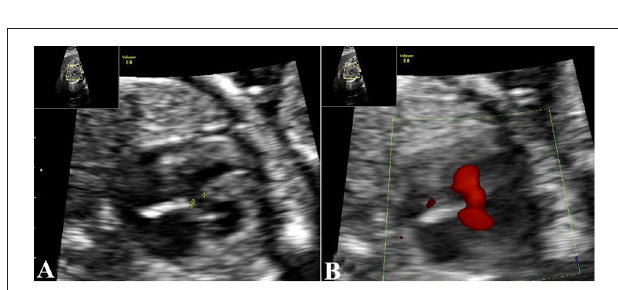
FIGURE 2 | Echocardiography demonstrates cardiac malformations. (A) Echocardiography demonstrates a 0.21-cm interruption of continuity in the ventricular septal membrane. (B) trans-septal blood flow signals at the VSD. VSD, ventricular septal